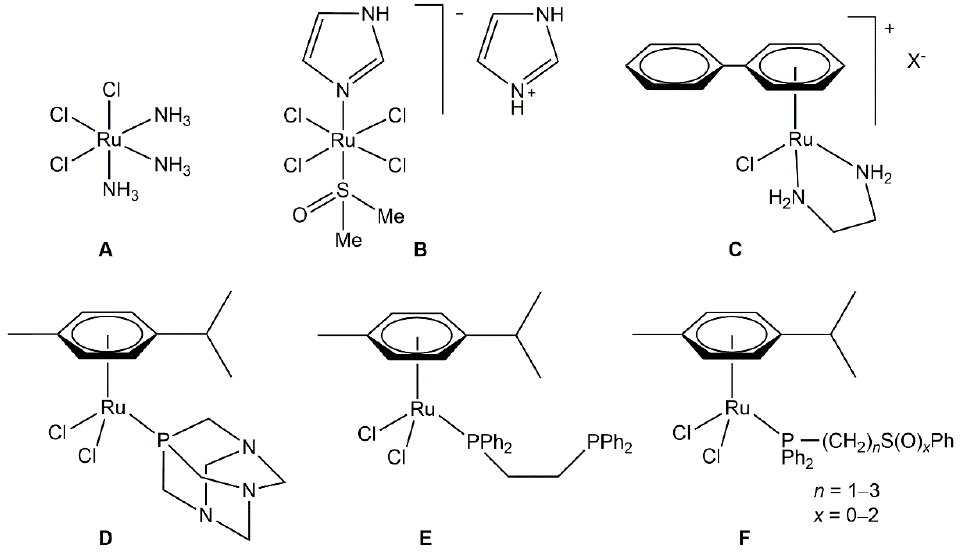
Figure 1. Examples of ruthenium(II/III) anticancer active compounds.